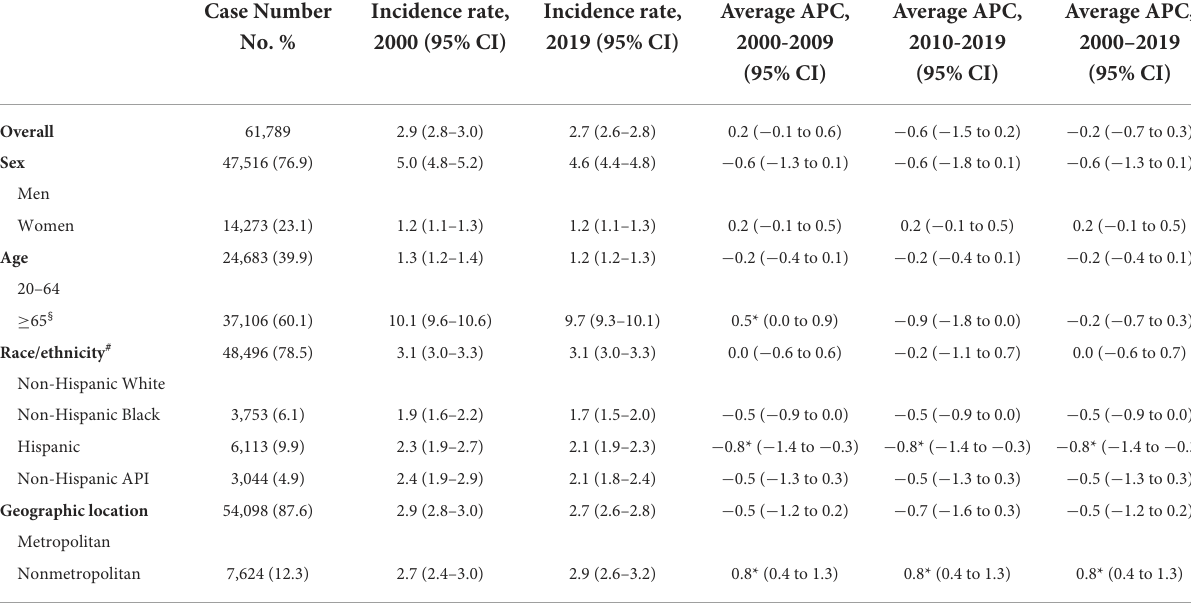
TABLE 2 Incidence rate and trend in cardia gastric cancer among US adults aged ≥ 20,